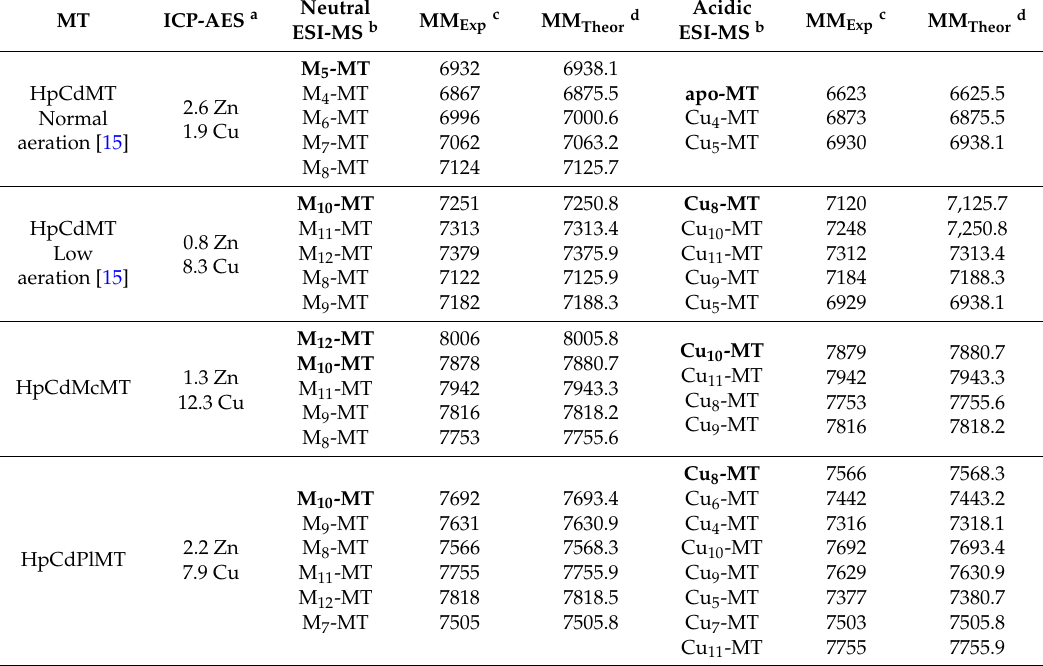
Table 2. Analytical characterization of the recombinant complexes obtained from Cu supplemented cultures of the HpCdMT mutants studied in this work. All data for the two mutant proteins correspond to normal aerated cultures, since no complexes could be recovered from low aeration conditions. For comparative purposes, data for the wild-type HpCdMT, recombinantly-synthesized in Cu-supplemented cultures grown at both aeration conditions, are included